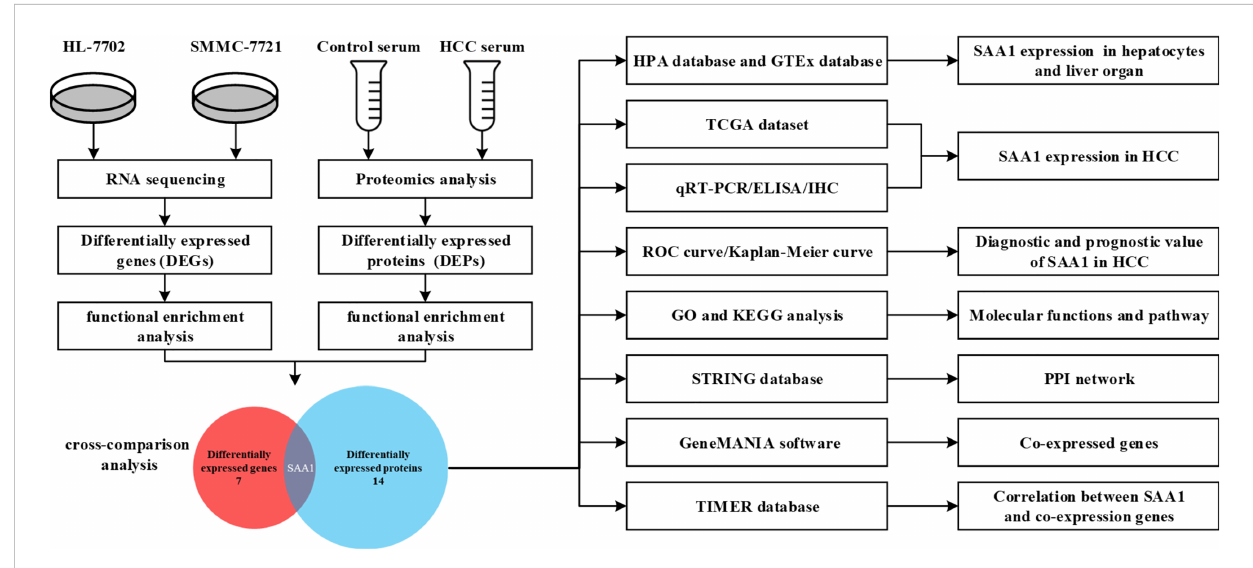
FIGURE 1 Flow chart of the